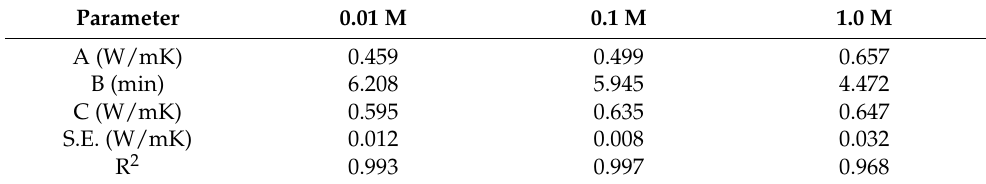
Table 1. Fitted model parameters for nanofluids prepared with rGO/Ag. Parameter 0.01 M 0.1 M 1.0 M A (W/mK)